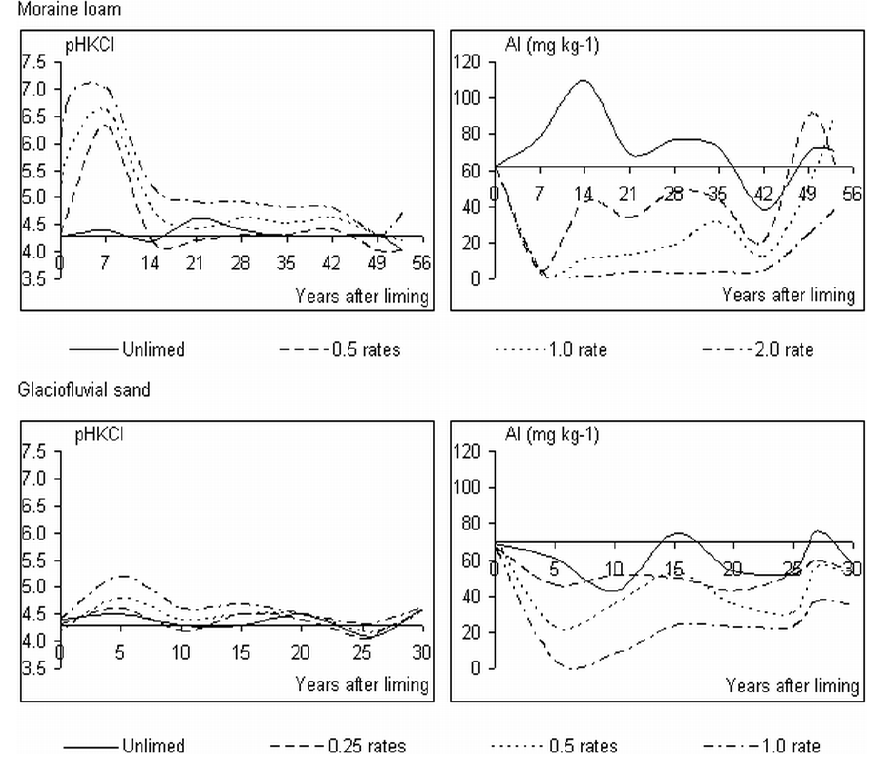
Fig. 4. The effect of primary liming on changes in soil acidity